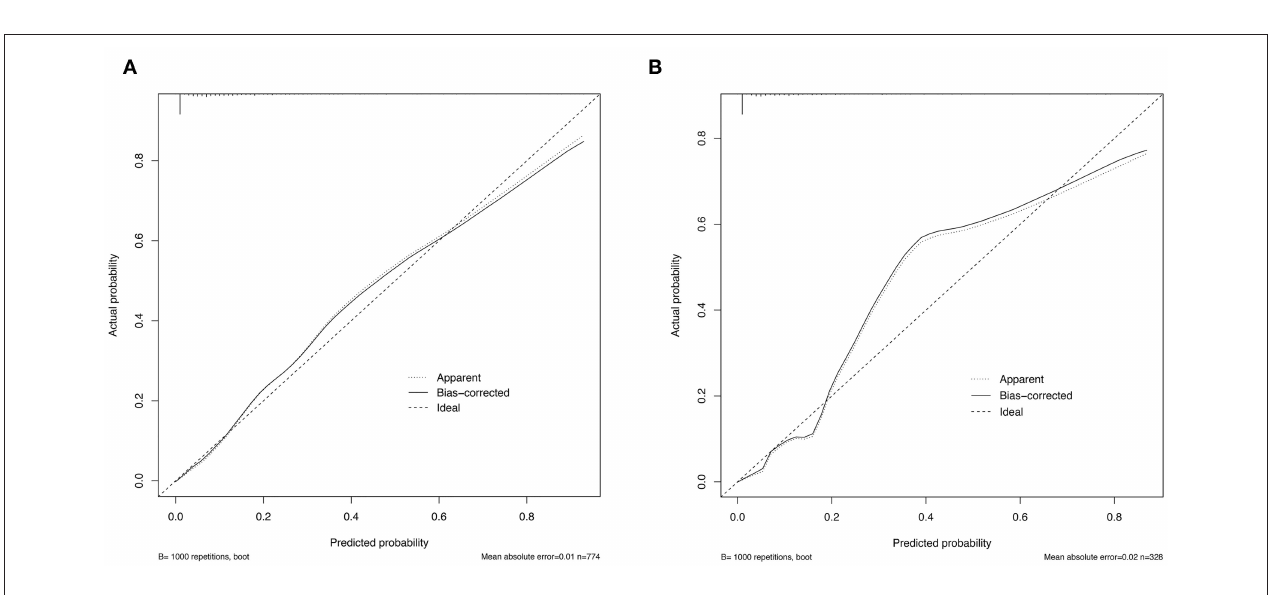
FIGURE 6 | Calibration curves for the nomogram model in the training cohort (A) and validation cohort (B)